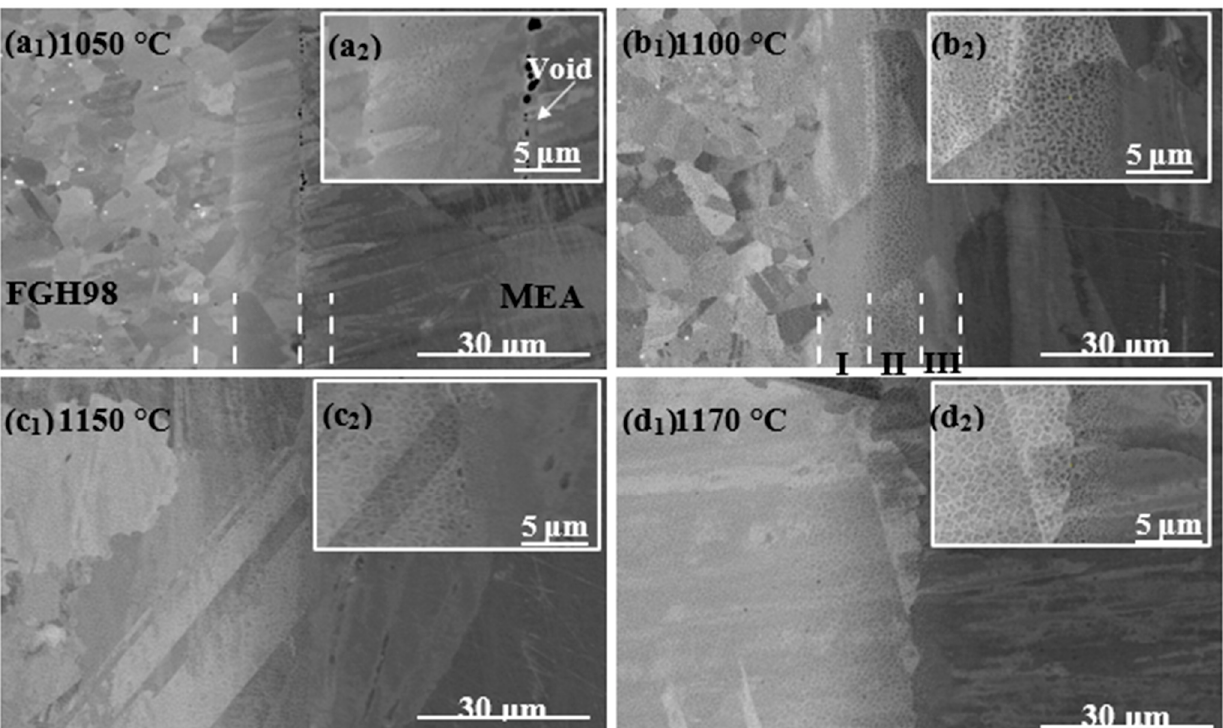
Figure 2. The morphology of joints bonded at different temperature, showing ( a 1 ) 1050 ◦ C, ( b 1 ) 1100 ◦ C, ( c 1 ) 1150 ◦ C and ( d 1 ) 1170 ◦ C. ( a 2 – d 2 ) magnified figures of zones marked by white rectangles.